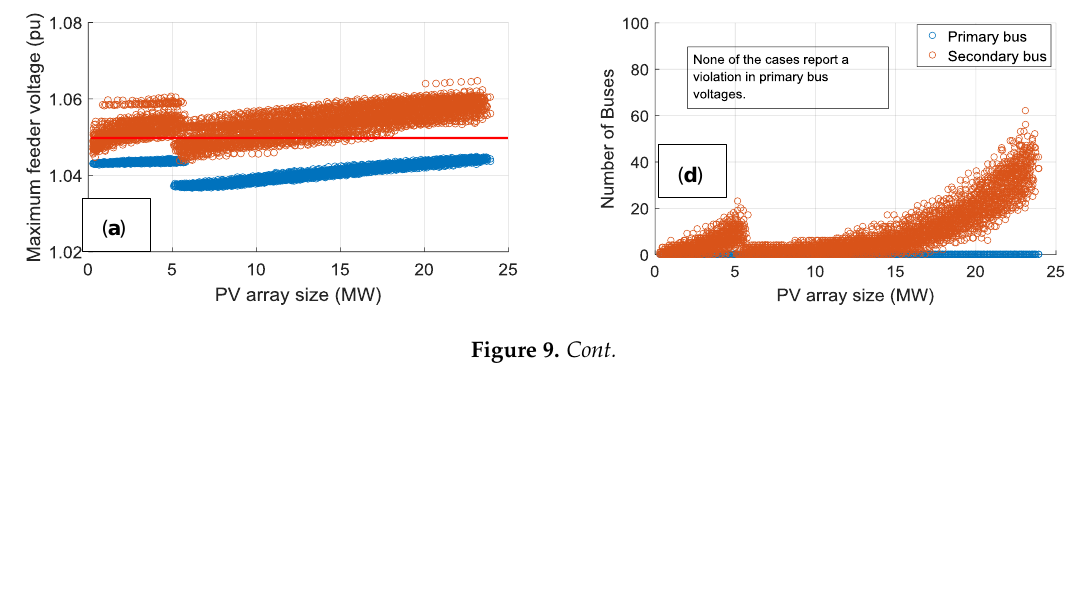
Figure 8. Reactive power supplied by the substation (MVAR)—Only smart inverter control.